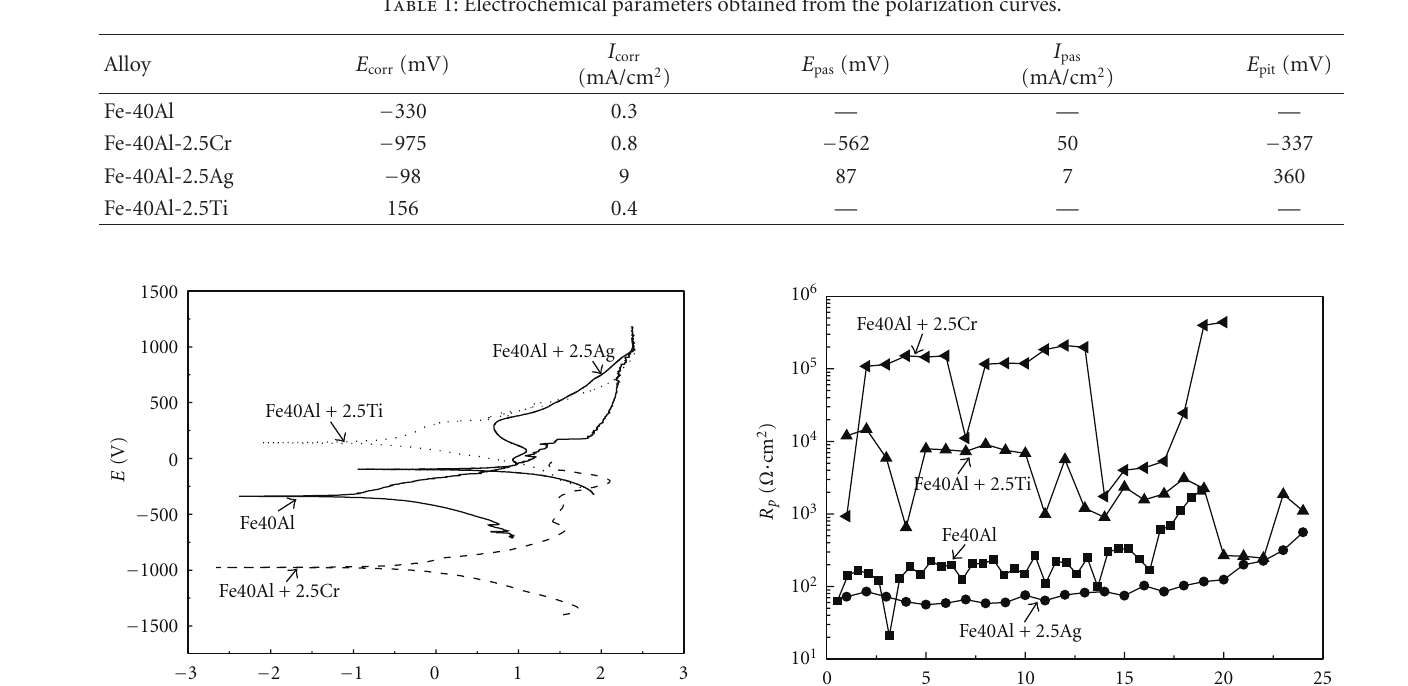
Table 1: Electrochemical parameters obtained from the polarization curves.